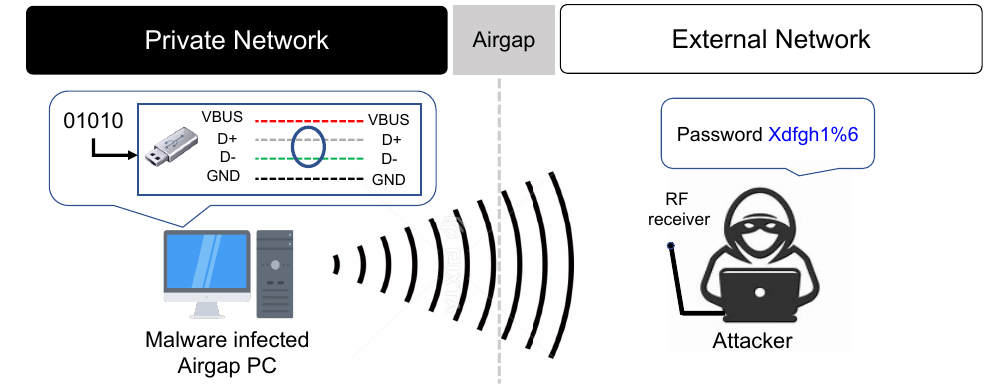
Figure 6. Conceptual diagram of air-gap attack using USB device data bus RF